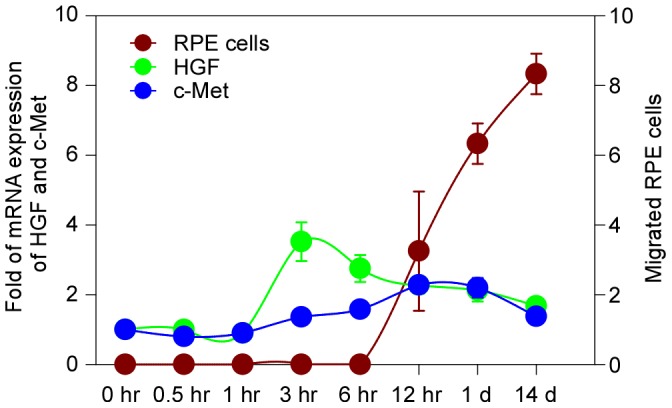
The expression of HGF and c-Met and the migration of RPE cells in B6 mouse after the laser-induced injury.We presume the accumulation of HGF expression might be able to trigger the expression of c-Met. Meanwhile, the c-Met expression positively affected the RPE cell migration after the laser injury.